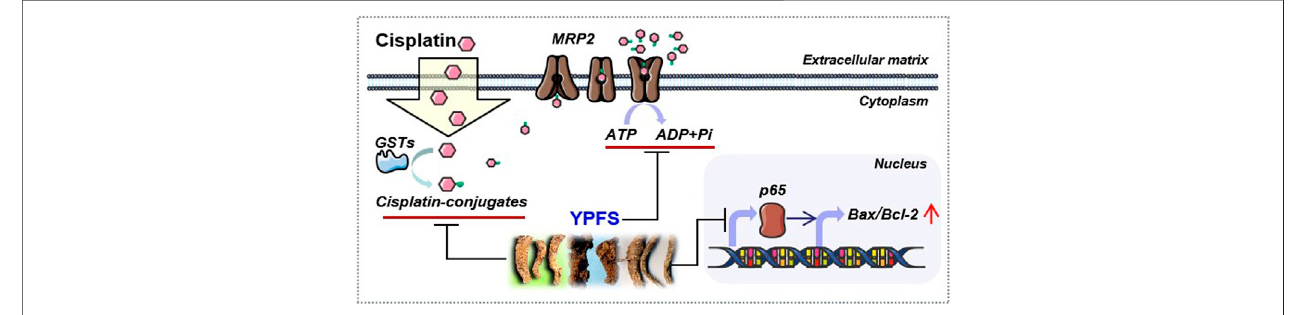
FIGURE 9 | Model of YPFS in tracking the cisplatin-resistance in a fast-onset manner in lung cancer cells. YPFS reduces the activities and expressions of ATP- binding cassette transporters and the levels of GSTs, consequently increases intracellular cisplatin in A549/A549-DDP cells. In parallel, YPFS downregulates the expression of p65 subunit of NF- κ B leading to a higher ratio of Bax/Bcl-2. Finally, YPFS synergize with cisplatin in triggering cell death.